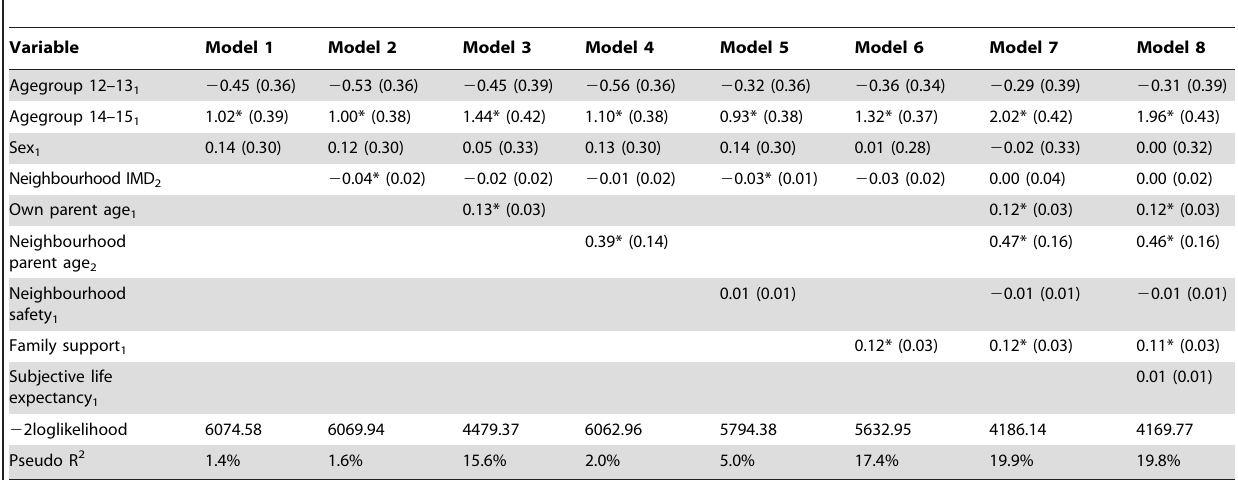
Table 2. Summary of multilevel regression models with ideal age for parenthood as the outcome